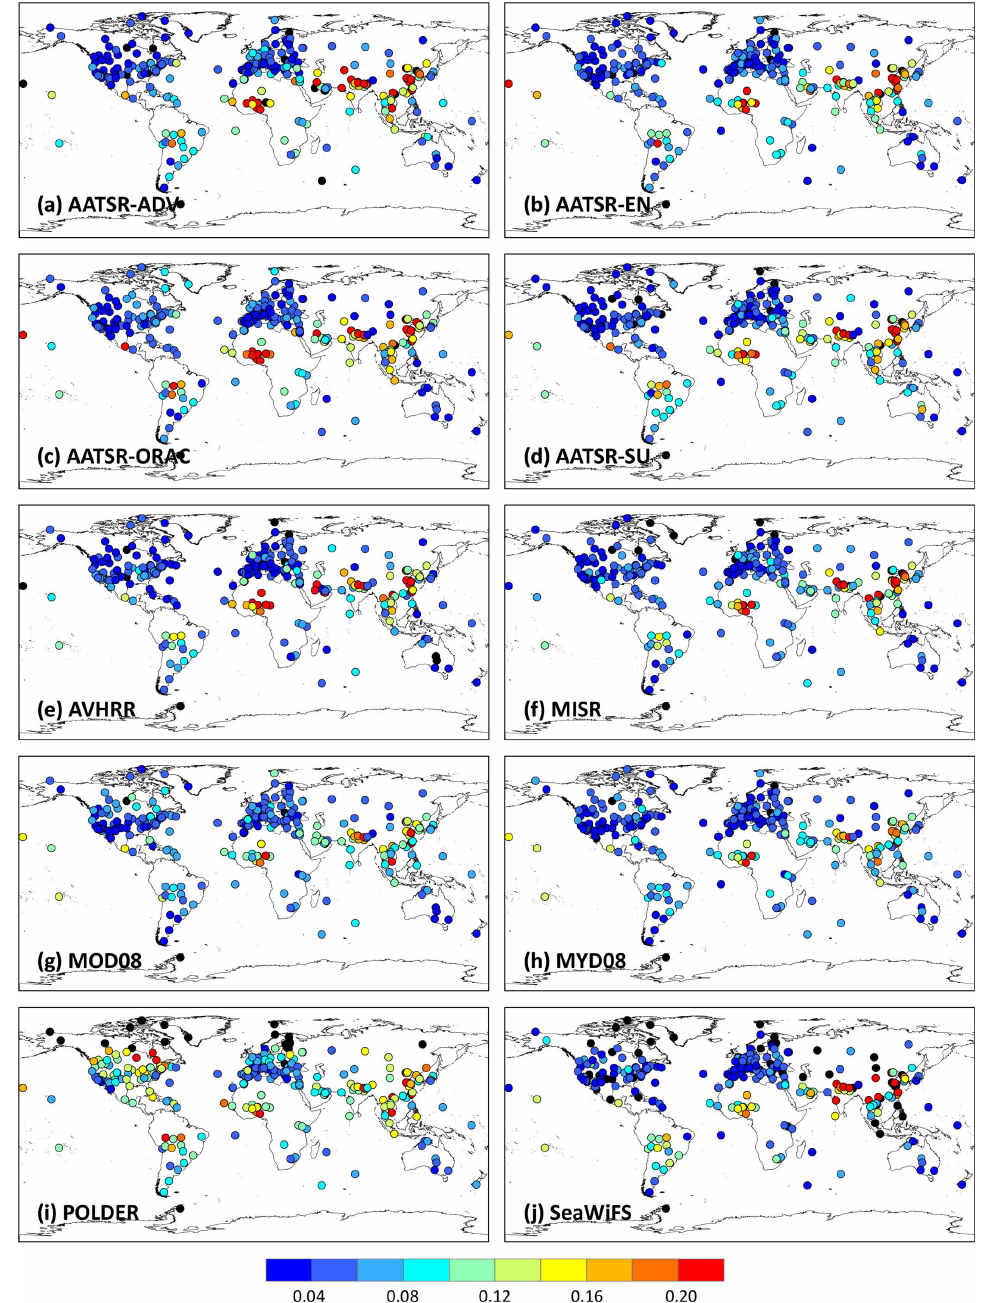
Figure 5. Same as Fig. 4 but for